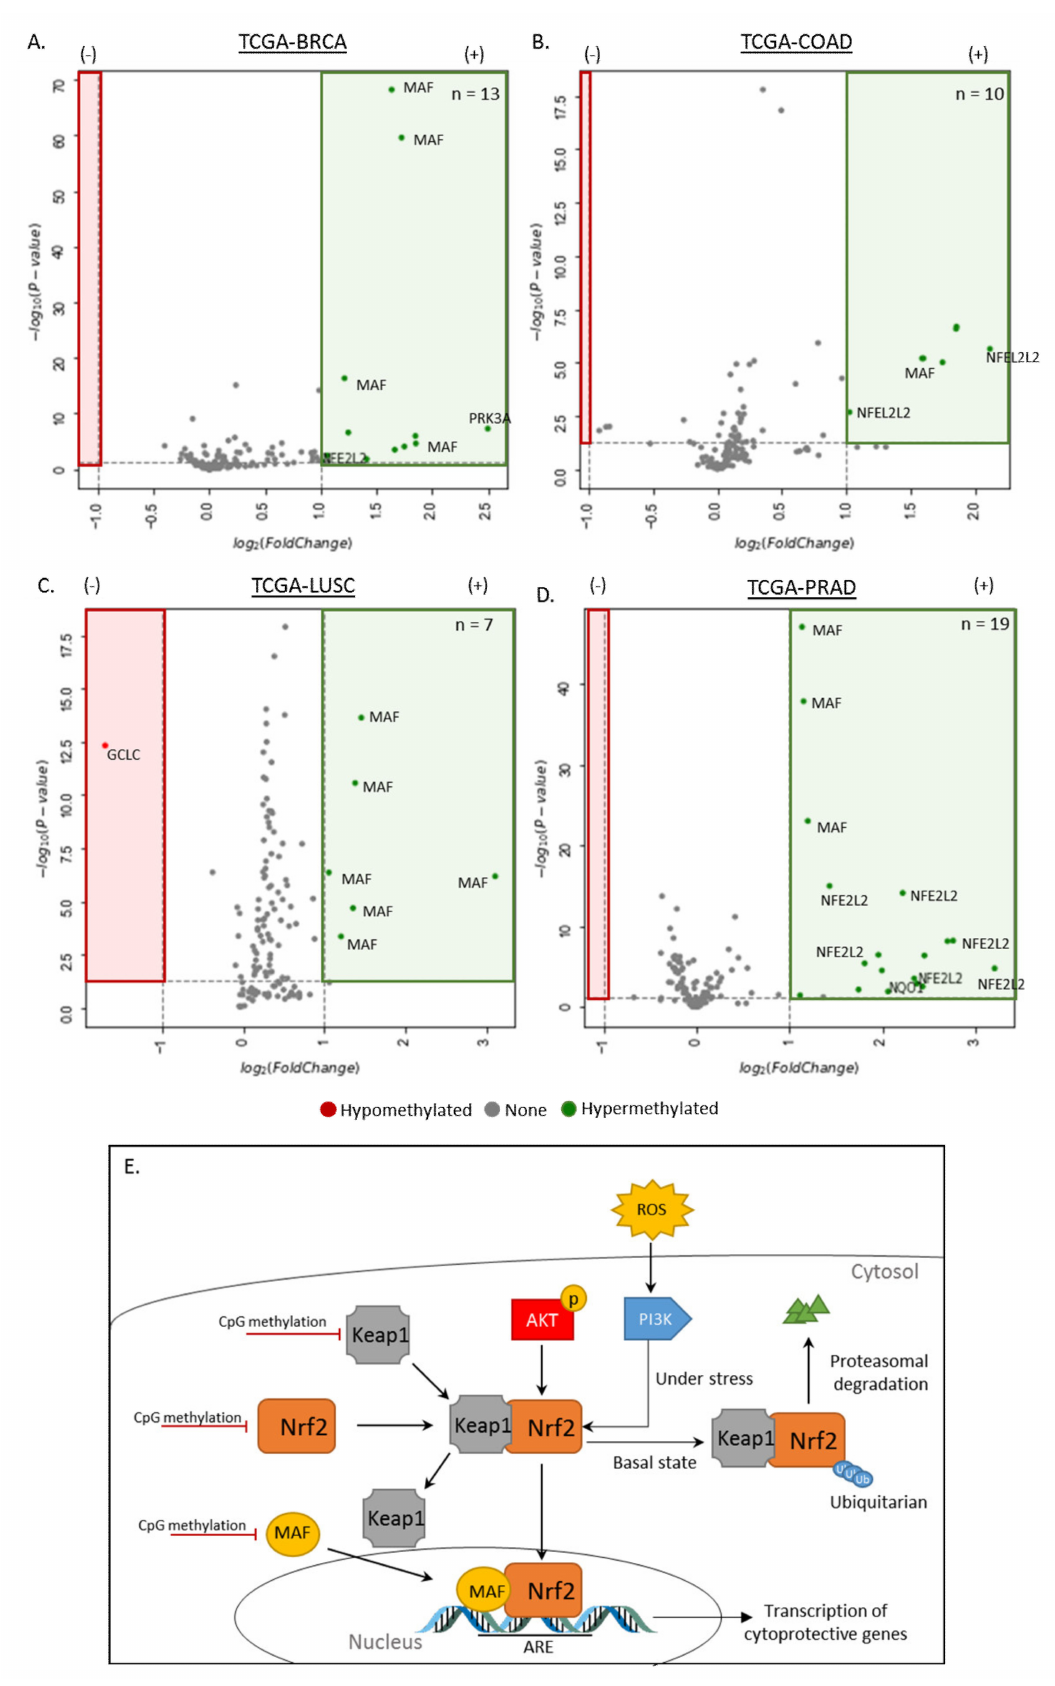
Figure 2. Hypermethylated genes in the dysregulation of the NRF2-KEAP1 and PI3K pathway in